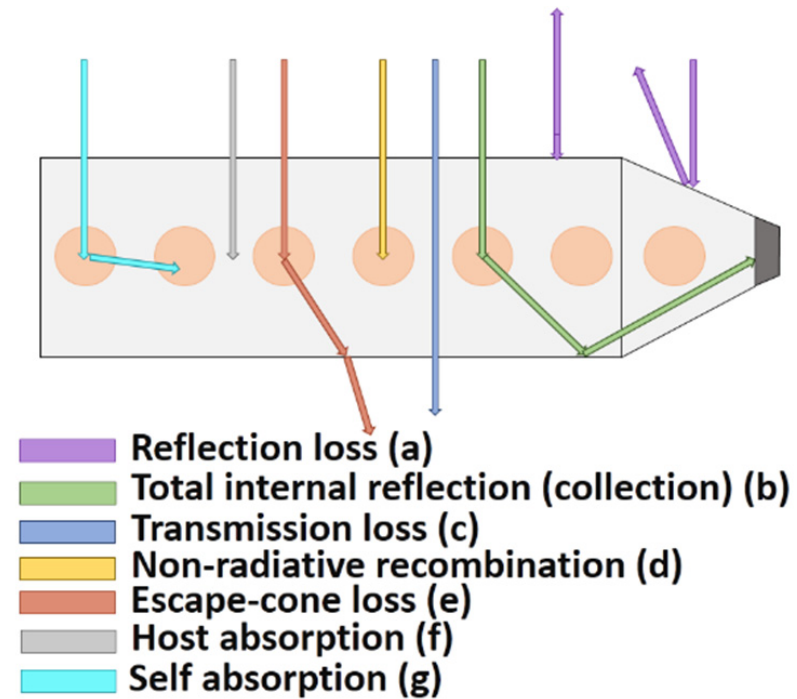
Figure 2. Physical process in optical antenna.